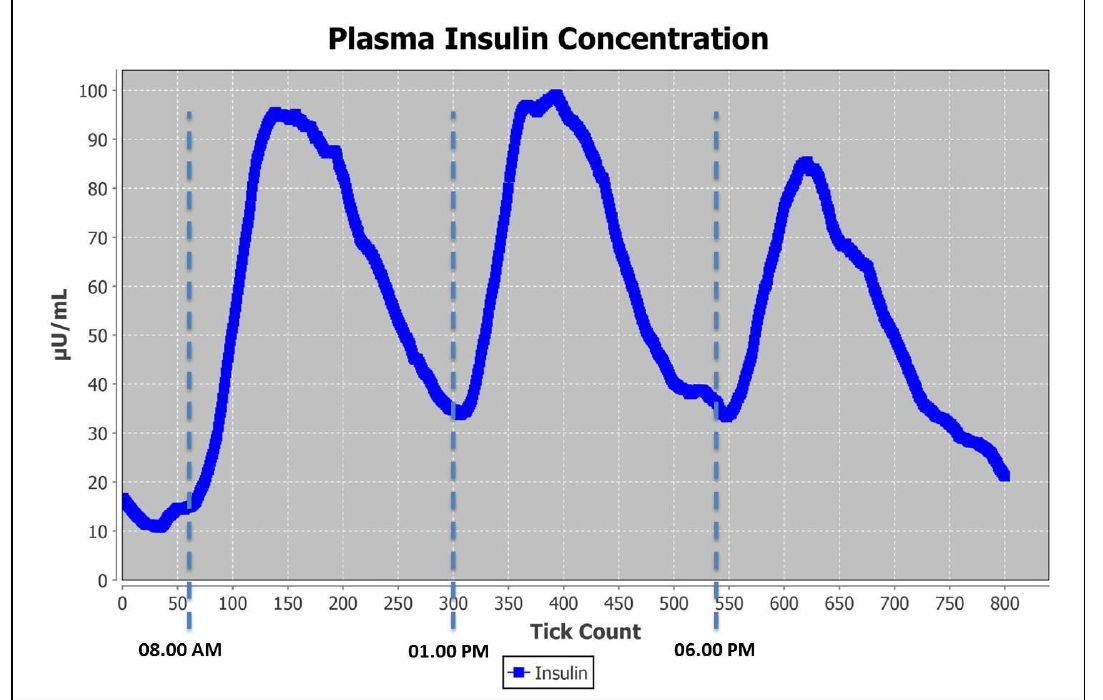
Figure 5. Insulin levels before and after a